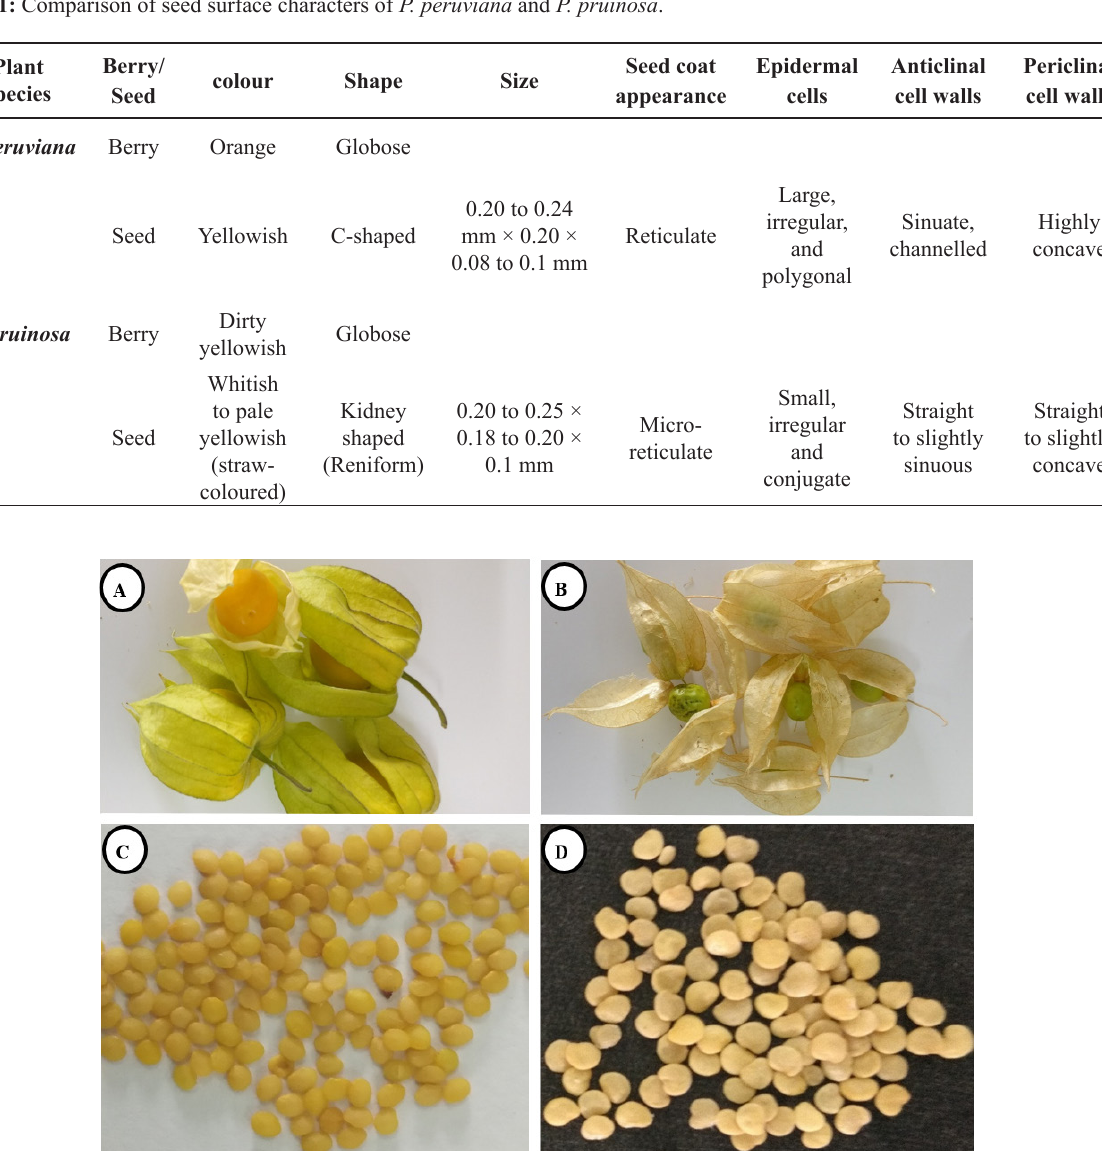
Table 1: Comparison of seed surface characters of P. peruviana and P. pruinosa .